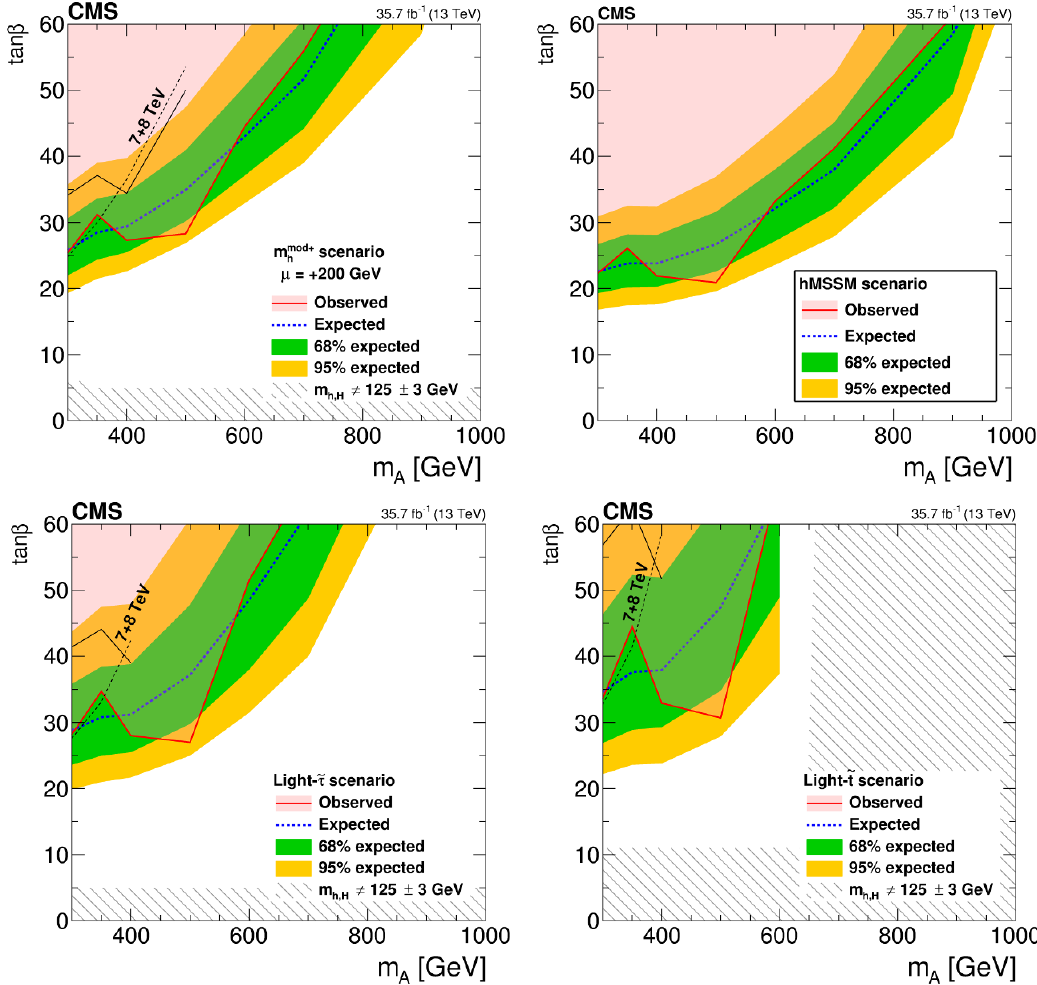
Figure 7 . Expected and observed upper limits at 95% CL for m A vs. the MSSM parameter tan (cid:12) in the (upper left) m mod+ benchmark scenario with (cid:22) = +200 GeV, in the (upper right) hMSSM, the h (lower left) light e (cid:28) , and the (lower right) light e t benchmark scenarios. The inner and outer bands indicate the regions containing 68 and 95%, respectively, of the distribution of limits expected under the background-only hypothesis. The excluded parameter space is indicated by the red shaded